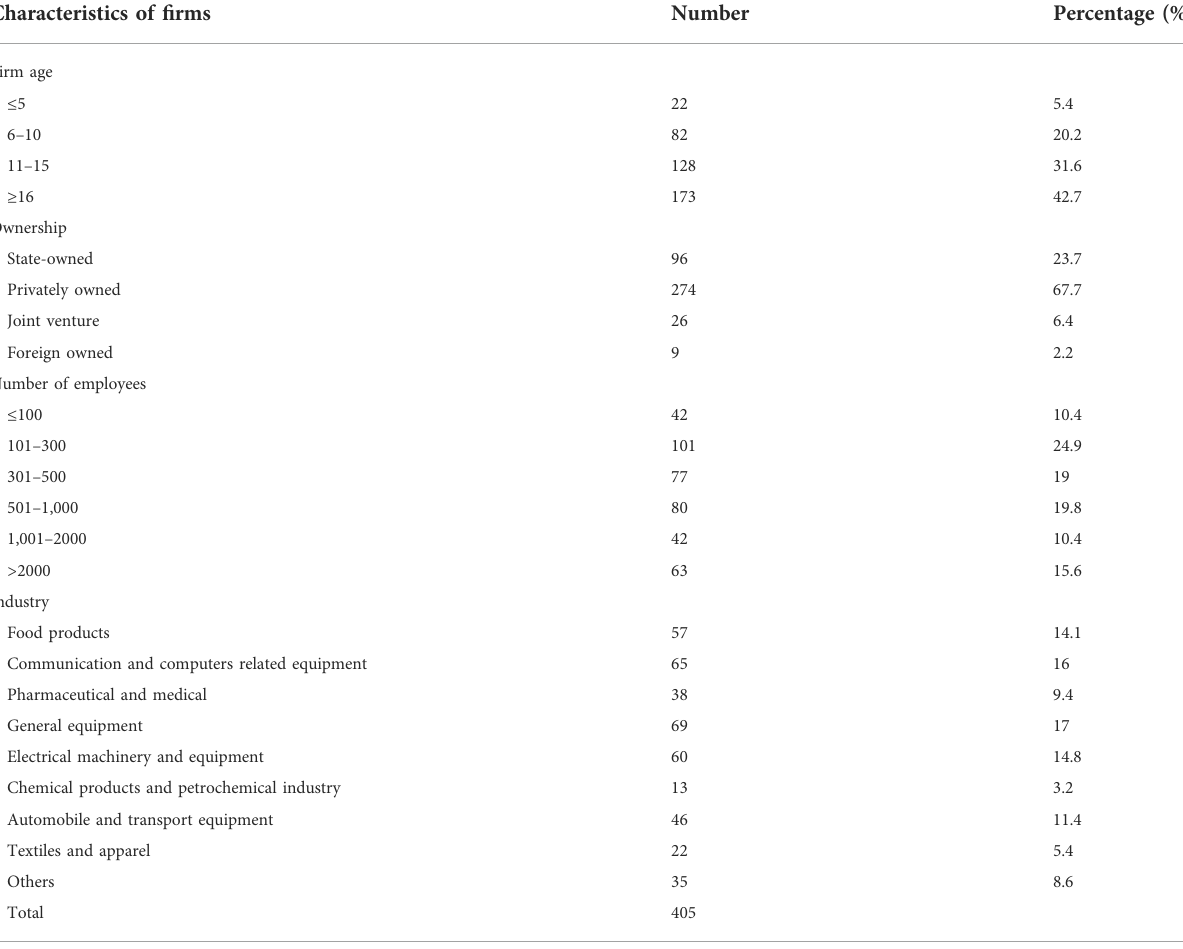
TABLE 1 Pro fi le of sampled fi